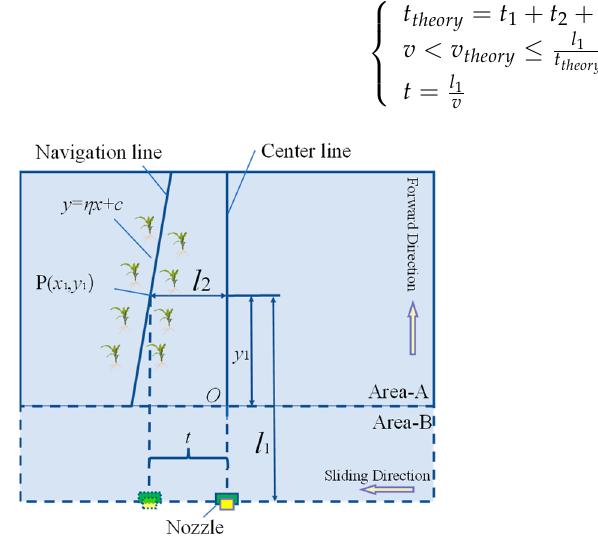
Figure 10. Delay compensation model.